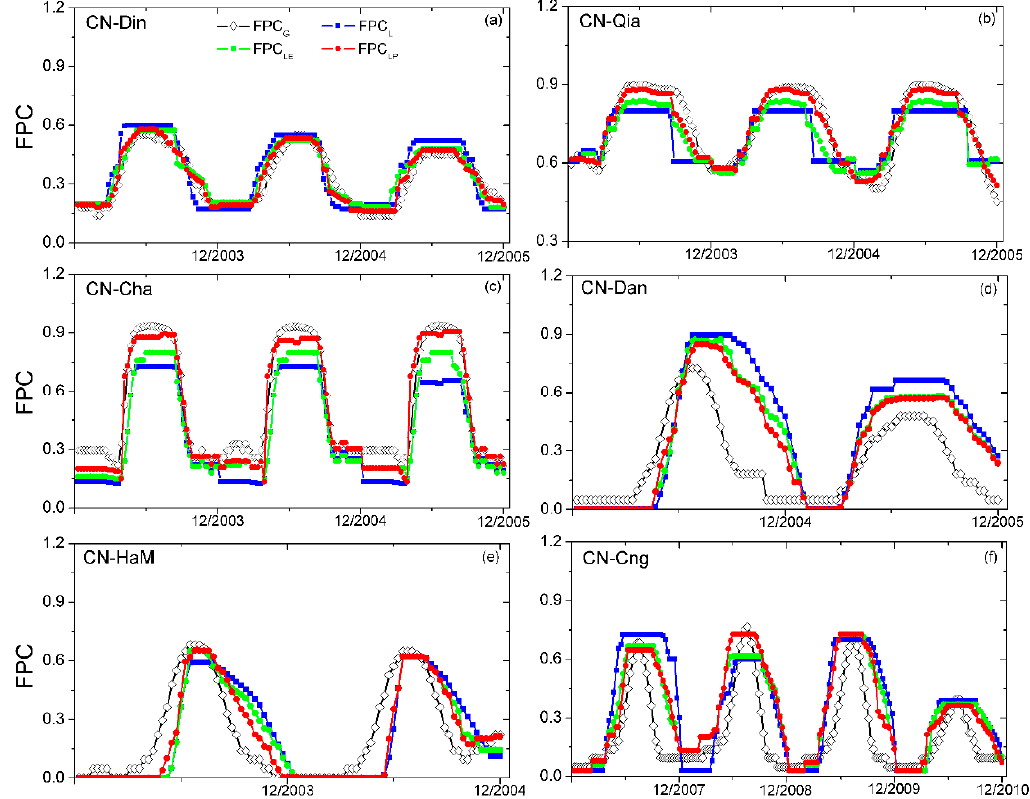
Figure 3. ( a – f ) Comparison of simulated eight-day FPC ( FPC L , FPC LE , and FPC LP ) and GLASS FPC ( FPC G , calculated from GLASS LAI). FPC L represents FPC simulated from LPJ-DGVM, FPC LE and FPC LP represent FPC obtained from the assimilated LPJ-DGVM using the EnKF and PODEn4DVar, respectively, and FPC G represents GLASS FPC.